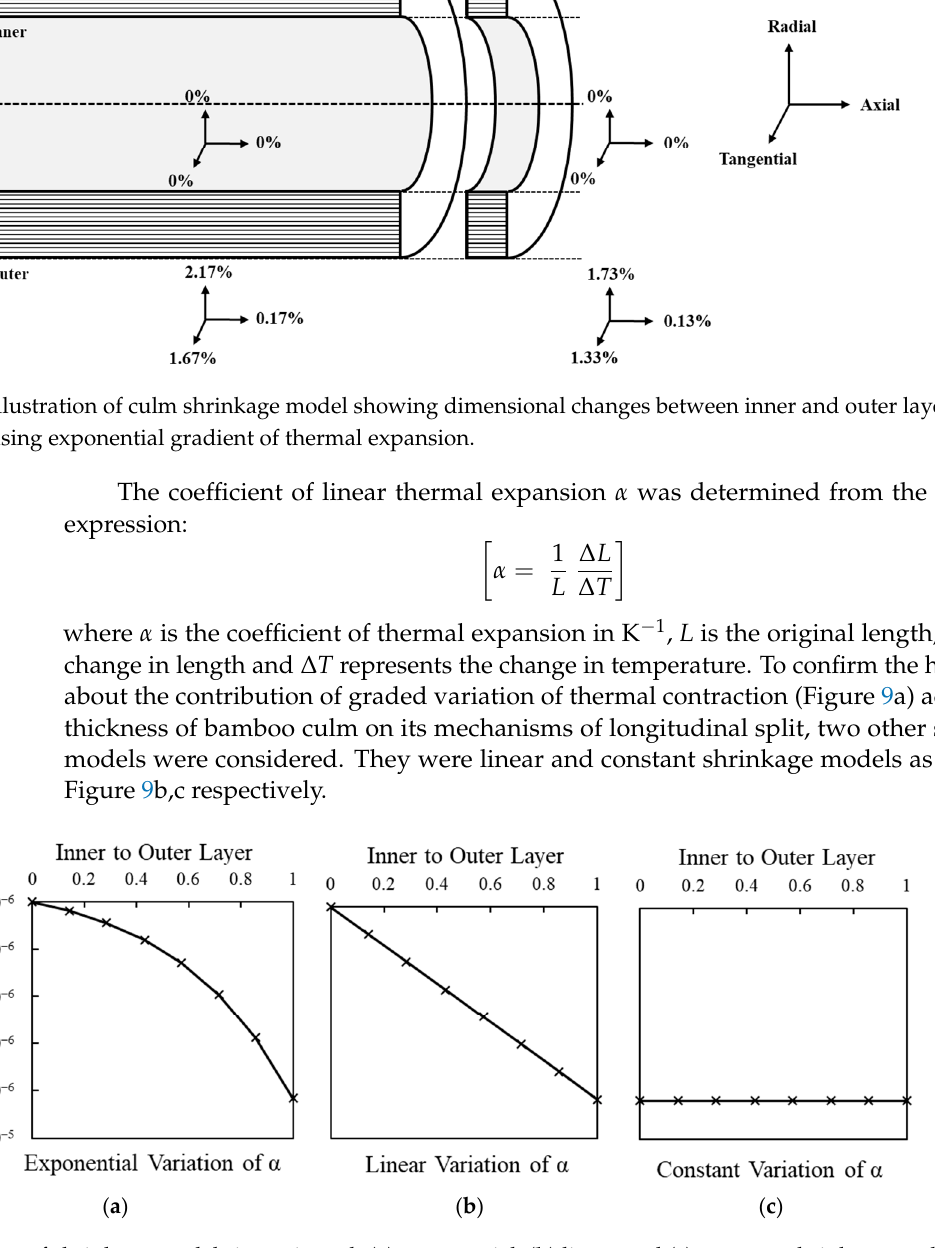
Figure 9. Three types of shrinkage models investigated: ( a ) exponential, ( b ) linear and ( c ) constant shrinkage models.